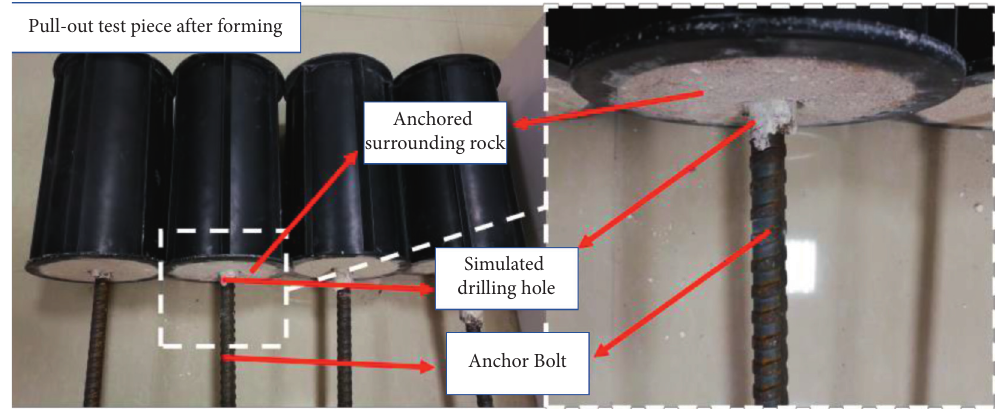
Figure 4: Preparation of the anchorage pull-out specimen (part).